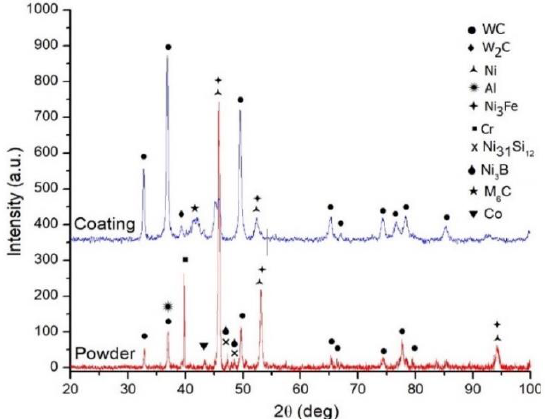
Figure 5. XRD patterns of the WC-Co/NiCrBSi coating and